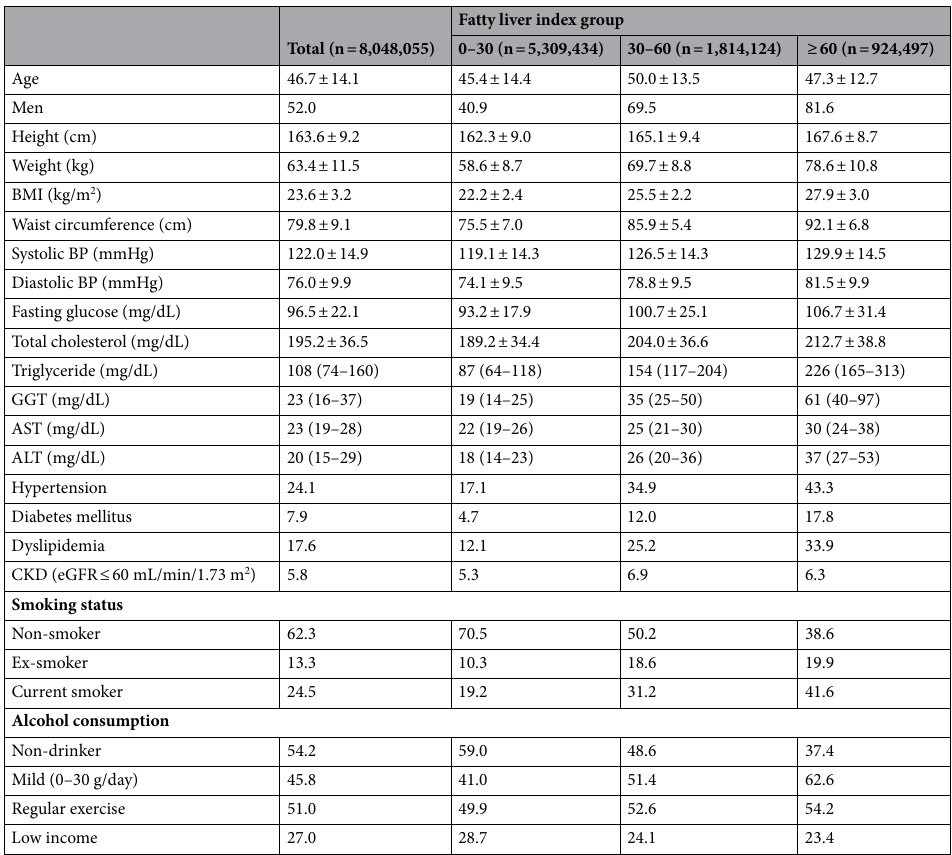
Table 1. Baseline characteristics of study subjects stratified by fatty liver index. Categorical variables are presented as percentage and continuous variables are presented as mean ± standard deviation or median (interquartile ranges). ALT alanine transaminase, AST aspartate transaminase, BMI body mass index, BP blood pressure, CKD chronic kidney disease, eGFR estimated glomerular filtration rate, GGT gamma-glutamyl transferase, HDL high density lipoprotein.